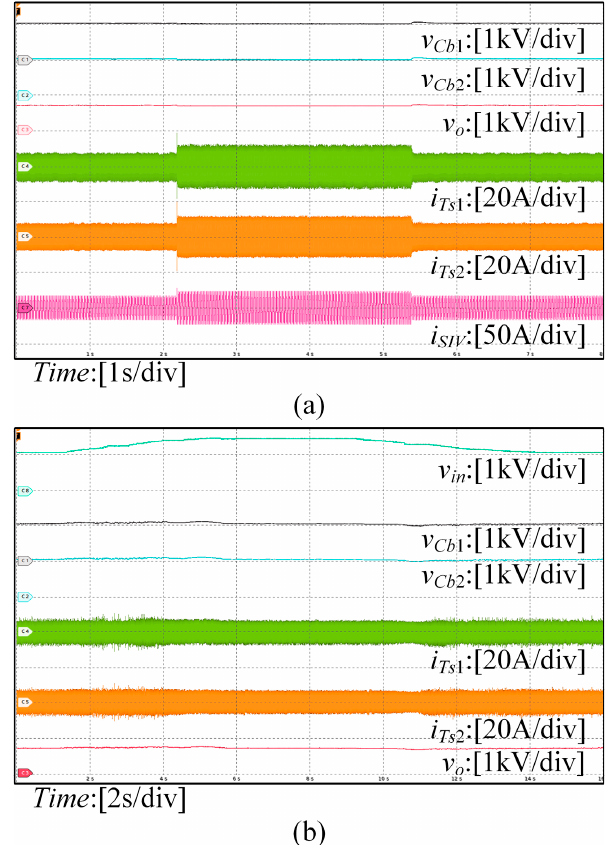
Figure 16. Experimental waveforms when the load and input voltage change. ( a ) Experimental waveform of load jump; ( b ) experimental waveform of input voltage variation.